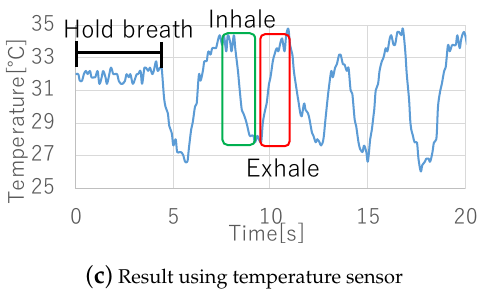
Figure 3. Result of three